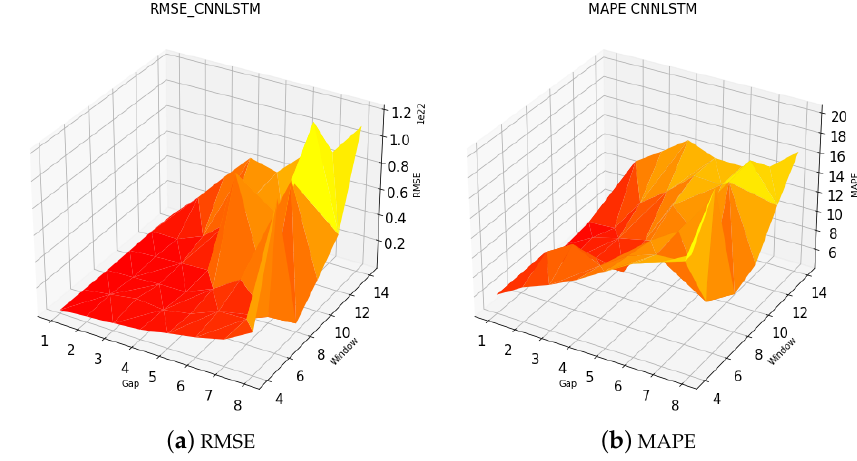
Figure 9. RMSE and MAPE for different historical window sizes (number of past samples) and gaps (years ahead), from CNNLSTM model.